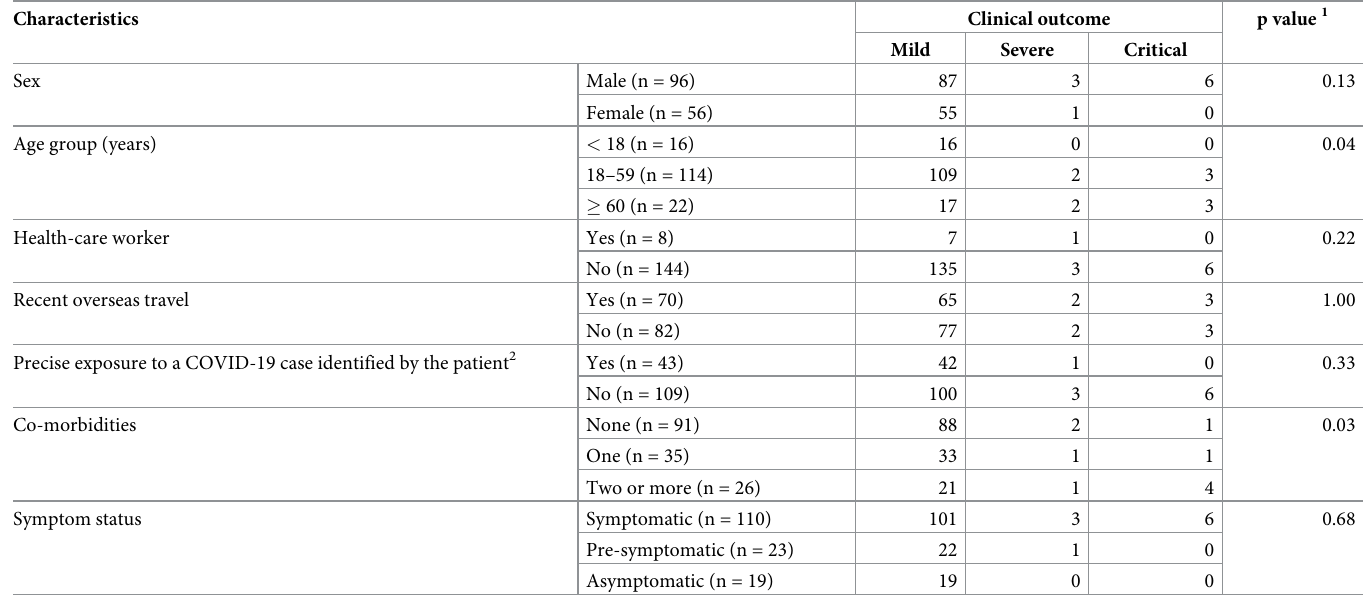
Table 1. Clinical outcome of patients by patient and disease